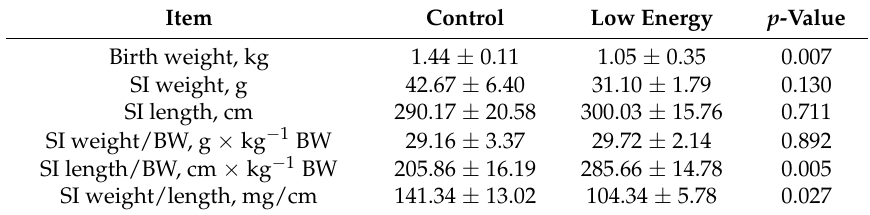
Table 3. Effect of different energy levels during gestation on intestinal index in newborn piglets.